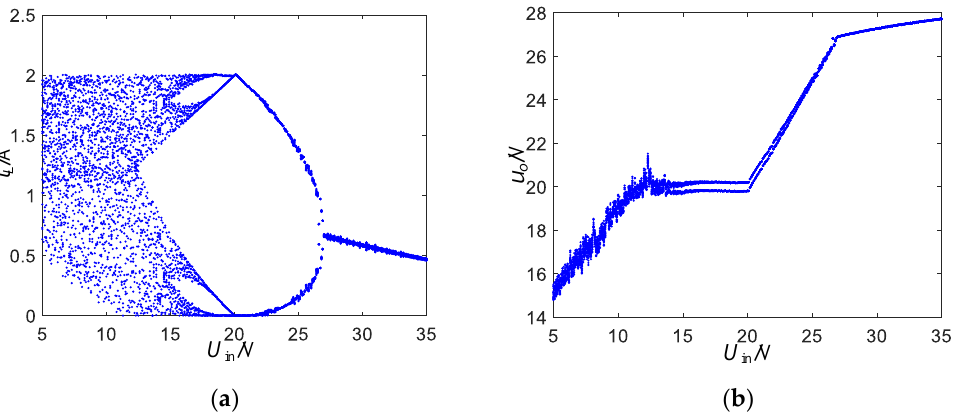
Figure 7. A bifurcation diagram of the integer-order converter with U in as the bifurcation parameter: ( a ) the inductive current i L ; ( b ) the output voltage u o . boost converters is shown in Table 3. Table 3. The input voltage value range of the fractional-order and integer-order DCM buck – boost converters.